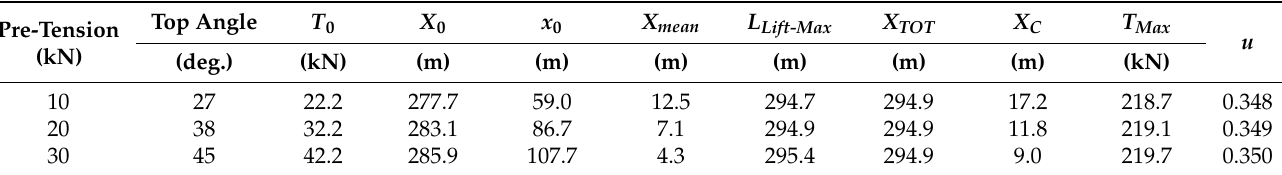
Table 13. Case 1, Minimum Diameter = 36 mm, quasi-static results.